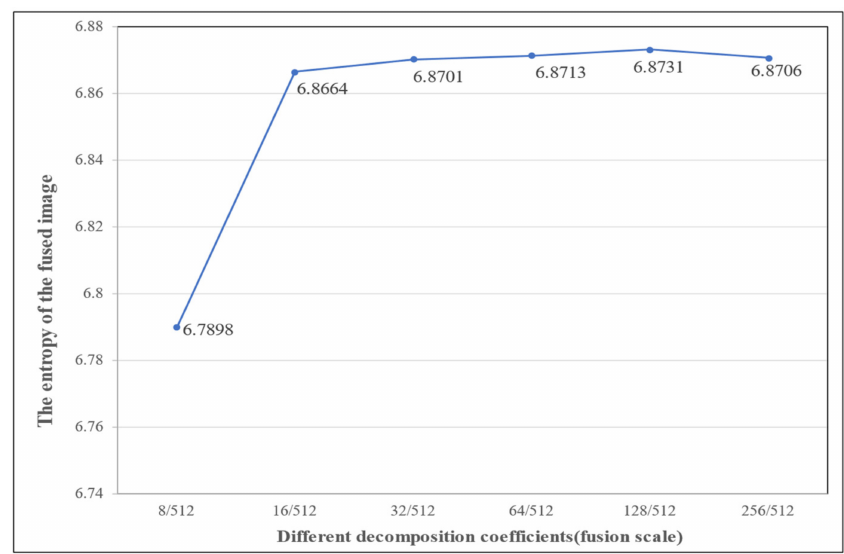
Figure 8. Information entropy line chart of fused images.